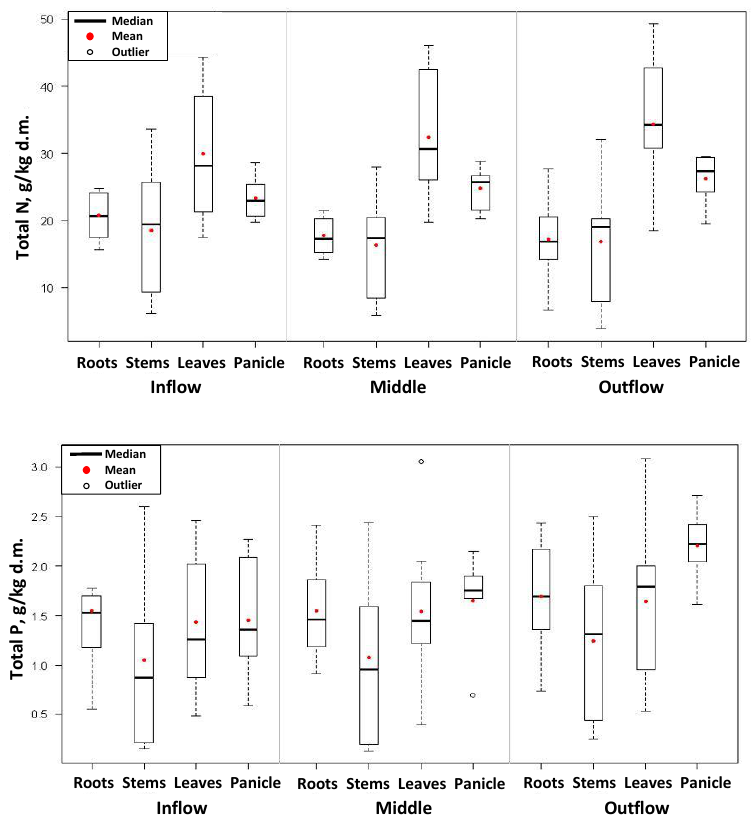
Figure 2. Total nitrogen and phosphorus in parts of common reed ( n = 10). Leaves and stems of reeds were characterized by the highest variability in nitrogen and phosphorus concentration in the subsequent months of growth. The accumulation of changed to a lesser